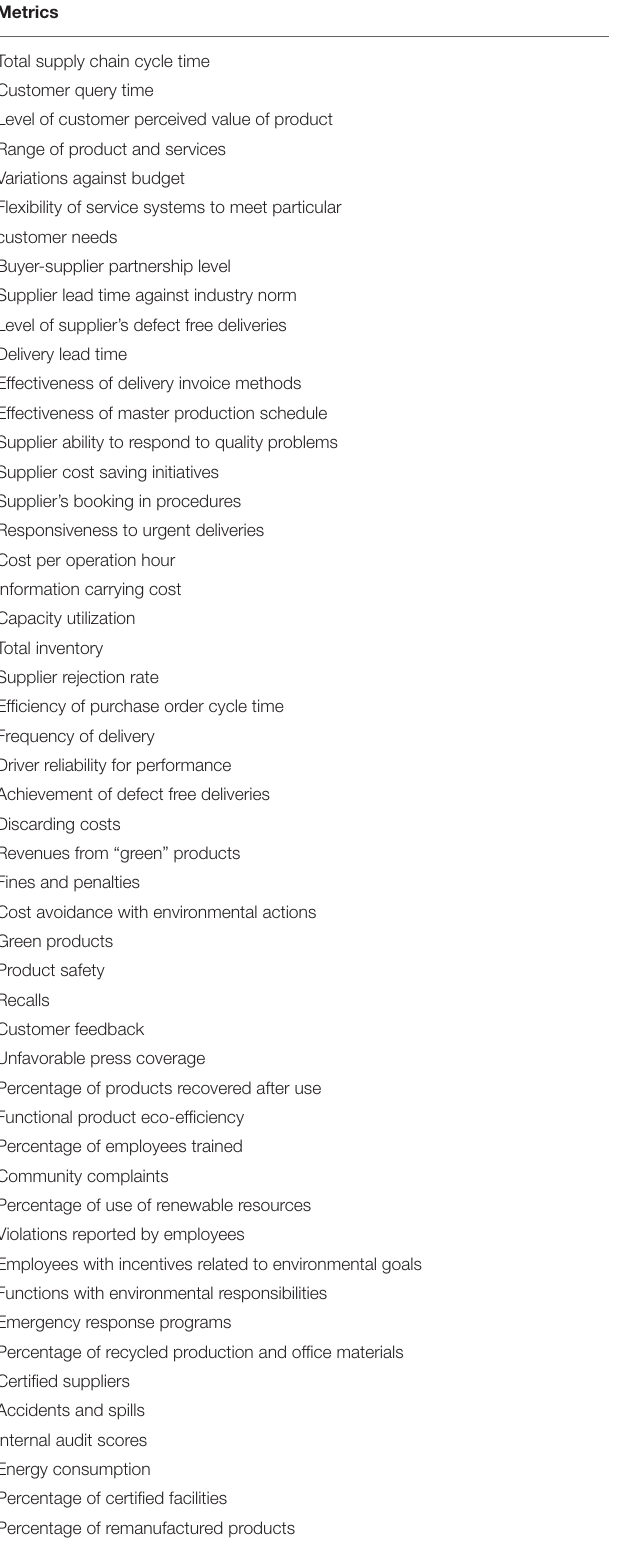
TABLE 8 | Metrics present in performance measurement